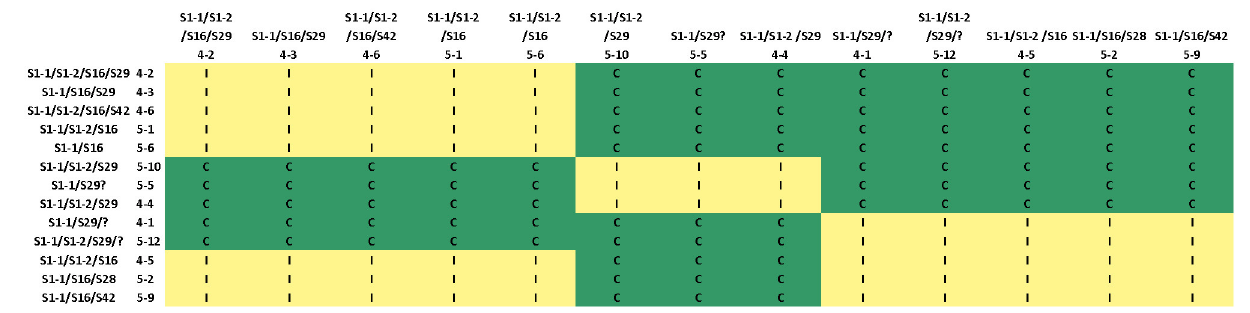
distinguish from PCR recombinants, particularly with only 200 bp of